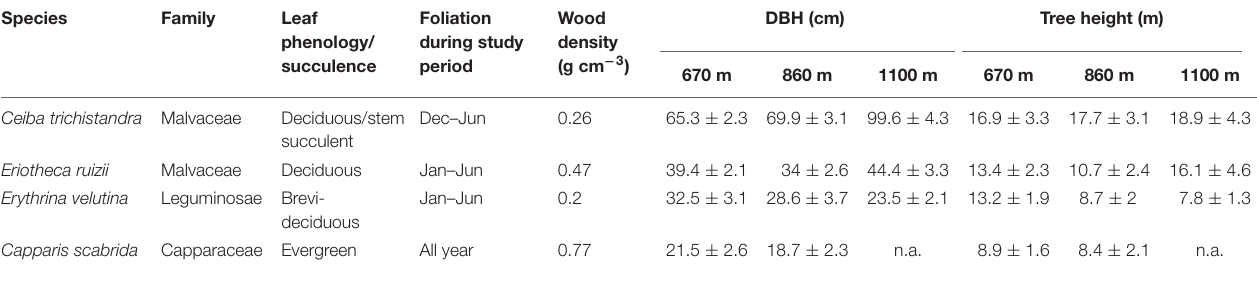
TABLE 1 | Characteristics of the four studied tree species (mean ± SD, n = 4 trees per elevation), wood density taken from Zanne et al. (2009).